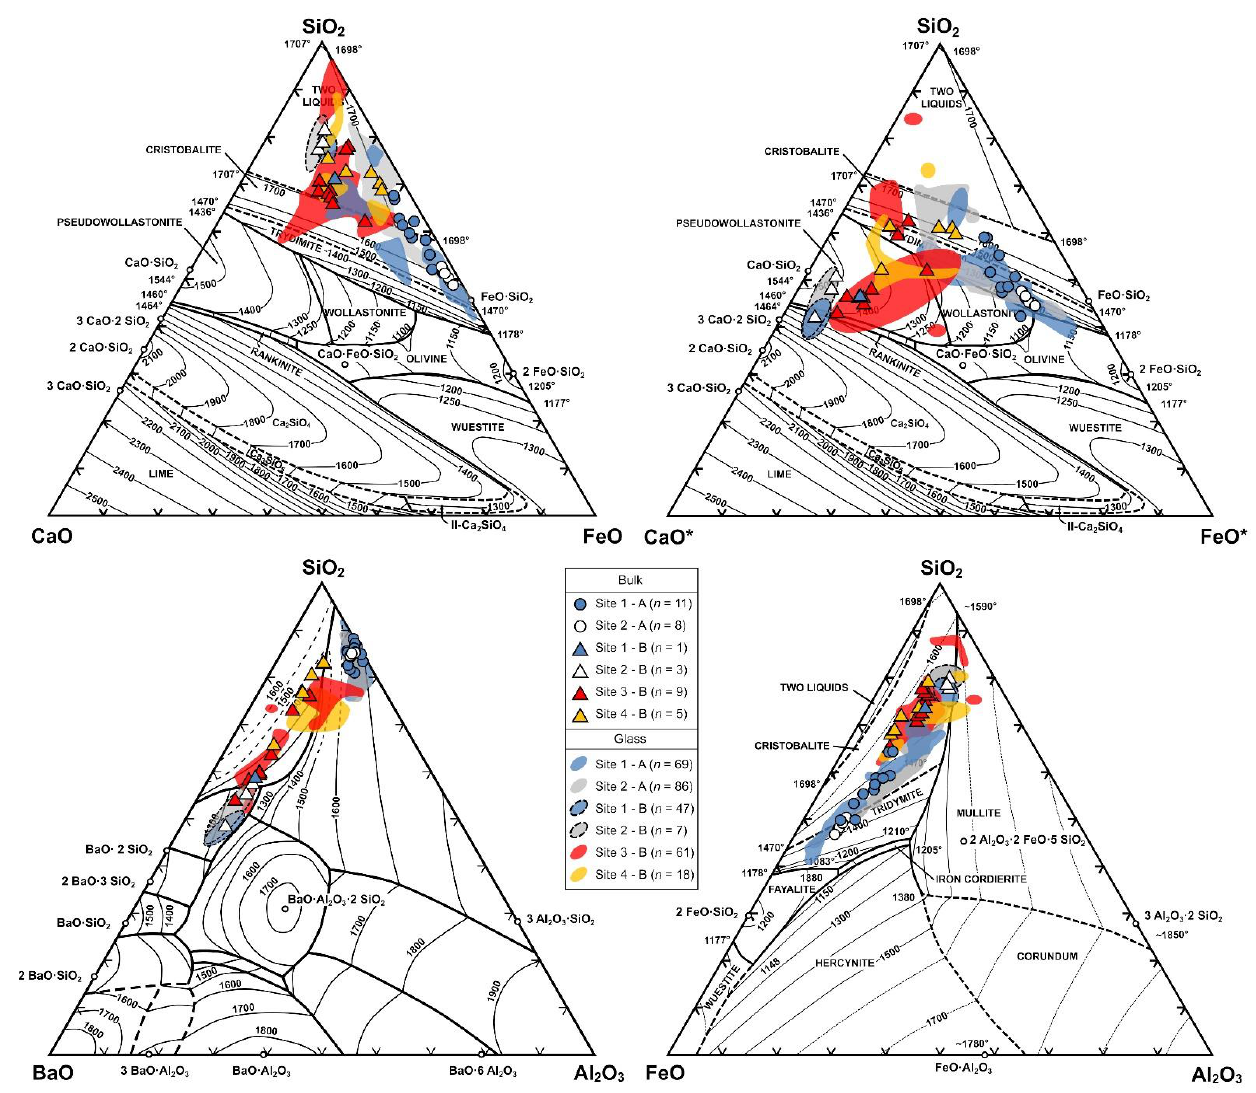
Figure 10. The smelting temperatures derived from ternary plots. System SiO 2 -CaO-FeO and SiO 2 - FeO-Al 2 O 3 according to [67], system SiO 2 -CaO*-FeO* according to [42], and system SiO 2 -BaO-Al 2 O 3 according to [68]. CaO* — (CaO + BaO + Al 2 O 3 ), FeO* — (FeO + ZnO + MnO). The calculated liquidus (Table 7) yields similar values for the same slag types (averages 1173 °C and 1186 °C for Type A slags and 1098 °C, 1101 °C, 1119 °C, and 1122 °C for Type B slags). The results are, with minor exceptions [40,41], comparable to other Czech and European localities (Table 8), and they are also relatively consistent with experimental observations. However, the application gives slightly underestimated values for Type B slags because it was developed for common rocks and therefore it does not account for high BaO contents [39]. The liquidus calculated from spot analyses is similar to bulk val- ues, since the Type B slags are composed mostly of glass (e.g., average 1119 °C for bulk and 1117 °C for glass from Site 3). On the other hand, Type A slags yield lower tempera- tures for glass (average 1106 °C for Site 1 and 1146 °C for Site 2) than for bulk (average 1173 °C for Site1 and 1186 °C for Site 2). Among the recent studies, [10] reports similar liquidus calculations in the range of 1200 – 1250 °C for 18th century Polish slags with ex- ceptions for the younger site, which gives 1350 – 1450 °C. Similarly, the authors mention an approximate 60 °C difference between the results obtained from bulk and glass